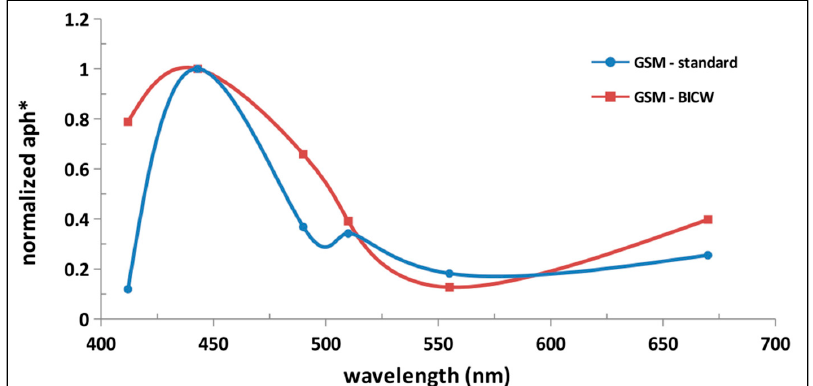
Figure 10. Plot of comparison between the averaged a* ph ( λ ) values computed within the locale scale configuration (hereafter GSM-BICW, red line) and the standard ones related to the default configuration (GSM—standard, blue line). All the a* ph ( λ ) values were normalized at 443 nm to facilitate the comparison.